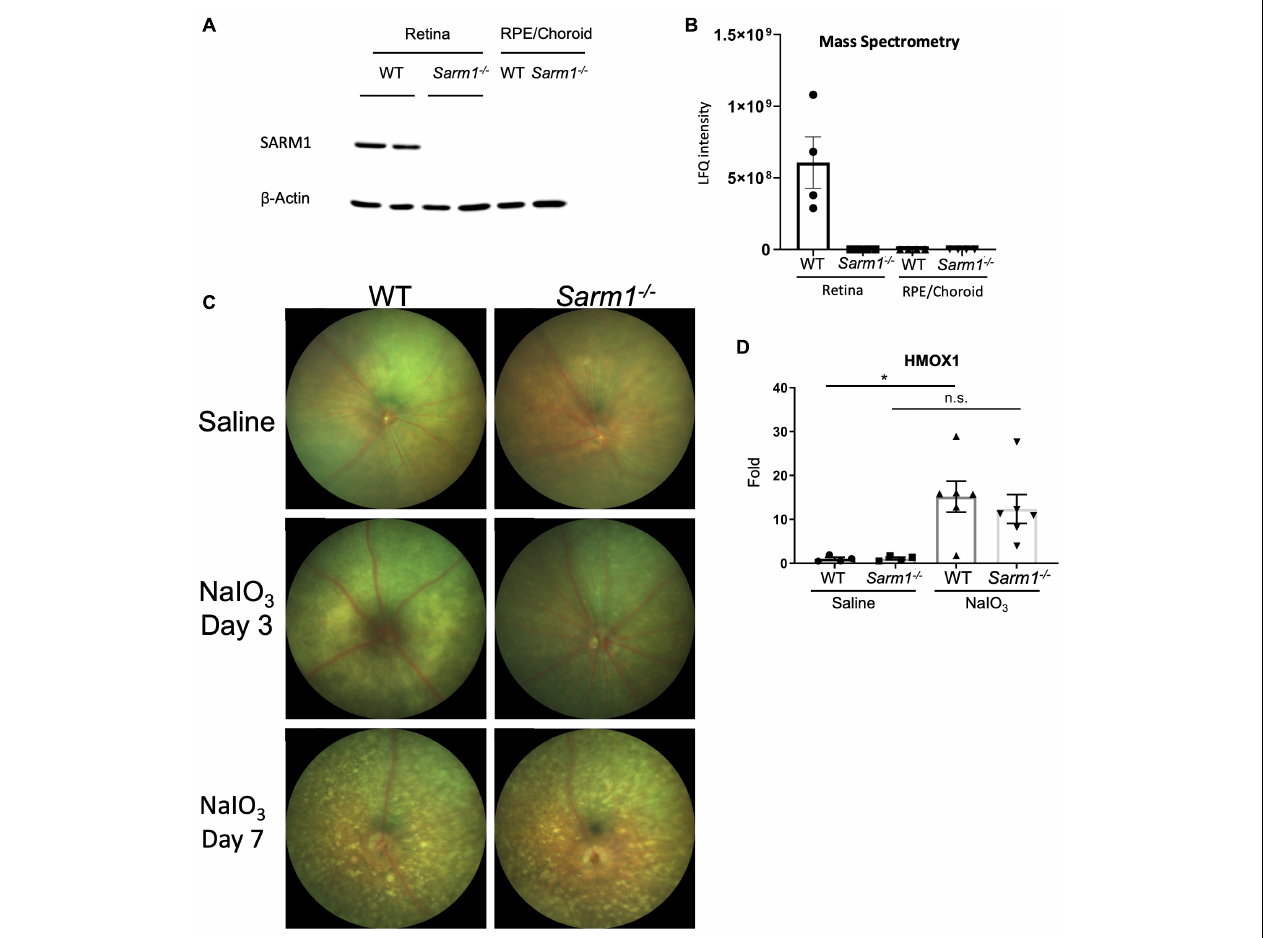
FIGURE 1 | SARM1 is expressed in the retina, not the RPE/choroid and has no effect on the pace of RPE degradation in the NaIO 3 model of retinal degeneration. Western blot analysis of SARM1 expression in the neural retina and RPE/choroid in C57BL/6J and Sarm1 − / − mice, Beta-actin is the loading control (A) . Mass spectrometry analysis of SARM1 expression in the neural retina and RPE/choroid in C57BL/6J and Sarm1 − / − mice, expression measured as label free quantification (LFQ) (B) . Colour fundus photographs of C57BL/6J and Sarm1 − / − mice 3-days and 7-days following administration of saline or NaIO 3 (50 mg/kg) (C) . RT-qPCR analysis of HMOX1 transcript levels in the retina 8-h following administration of NaIO 3 or saline (* P ≤ 0.05, by one-way ANOVA, n = 4 saline injected mice, n = 6 NaIO 3 injected mice) (D)